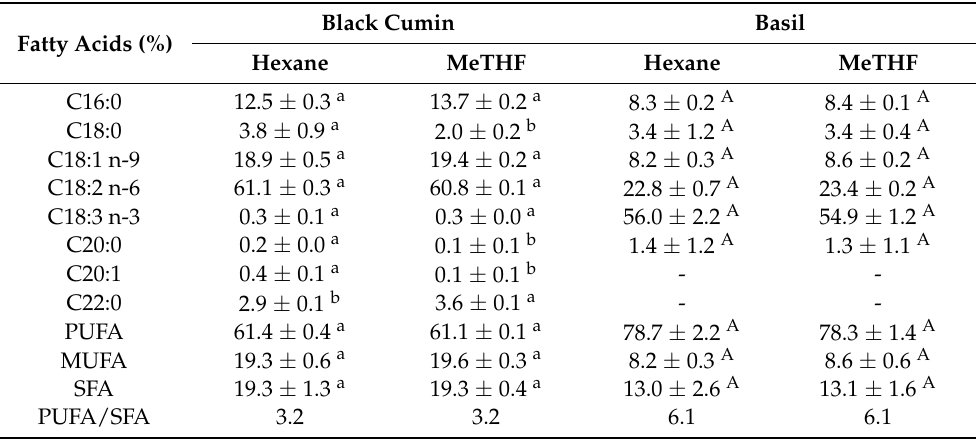
Table 2. Fatty acids composition (%) of black cumin and basil oils obtained with hexane and MeTHF extractions. Black Cumin Basil Fatty Acids (%) Hexane MeTHF Hexane MeTHF C16:0